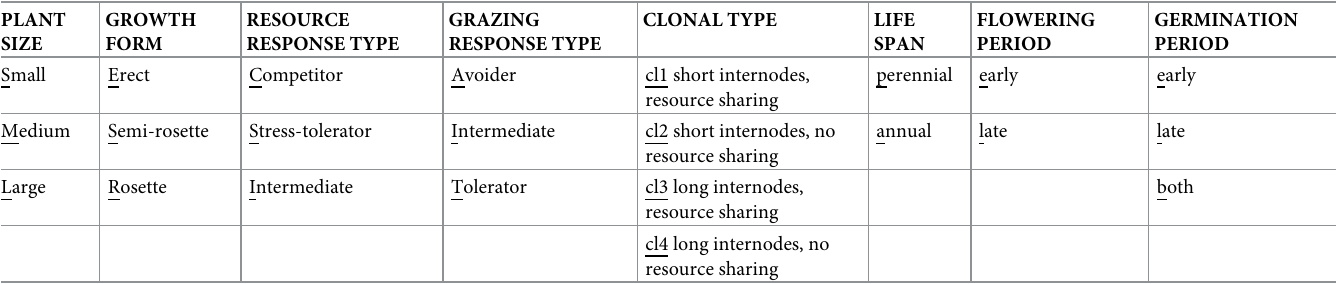
Table 2. Compilation of the specific PFT ID according to the major traits. PLANT SIZE